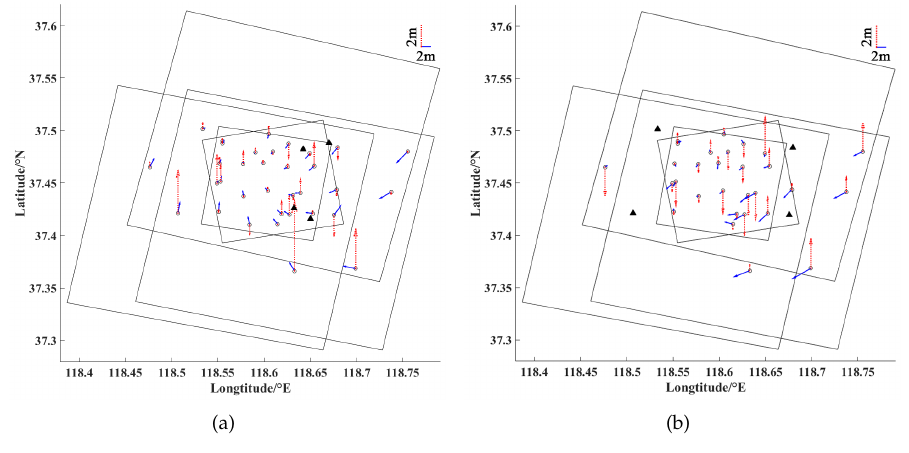
Figure 12. Geometric accuracy improvement analysis: ( a ) GF3, GF3, and GLAS combined geopositioning and ( b ) GF2 with four